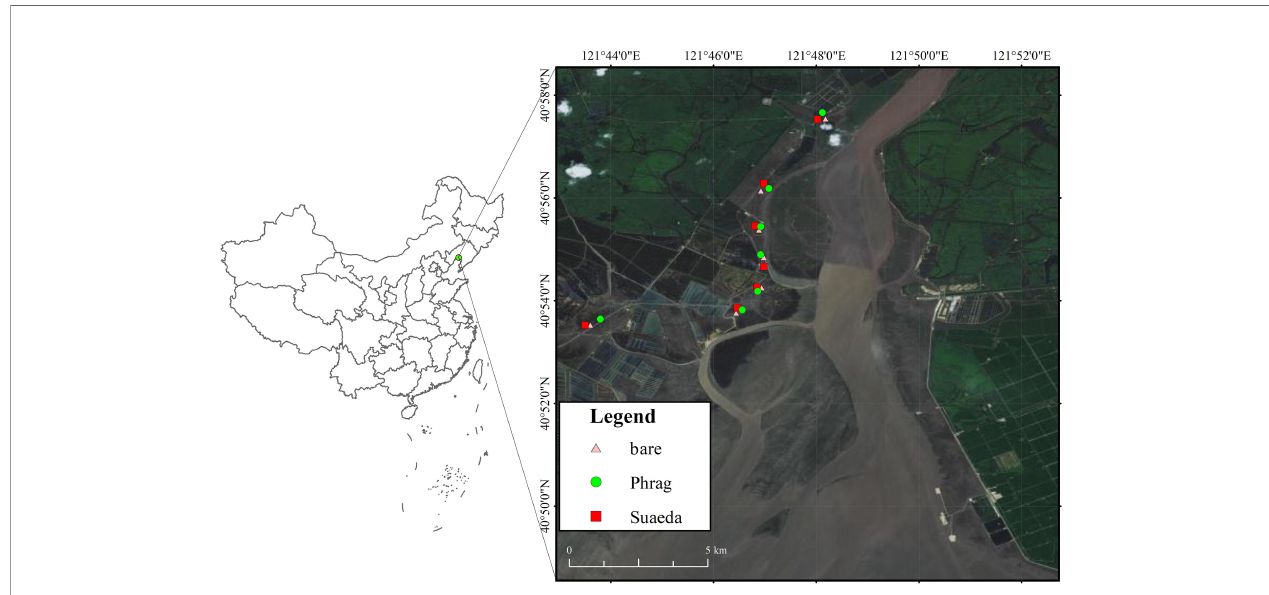
FIGURE 1 | Site Locations of the three wetland types: bare, unvegetated sediments ( ‘ bare ’ ), Phragmites australis marsh ( ‘ Phrag ’ ) and Suaeda heteroptera marsh ( ‘ Suaeda ’ ) in Liao River Delta,